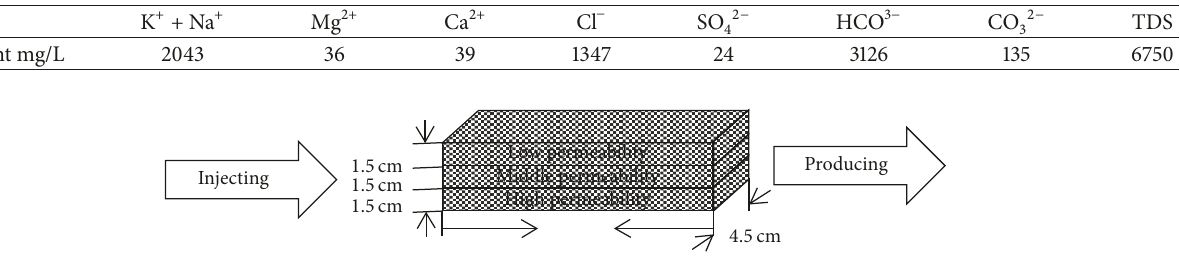
Figure 1: The two-dimensional vertical heterogeneous